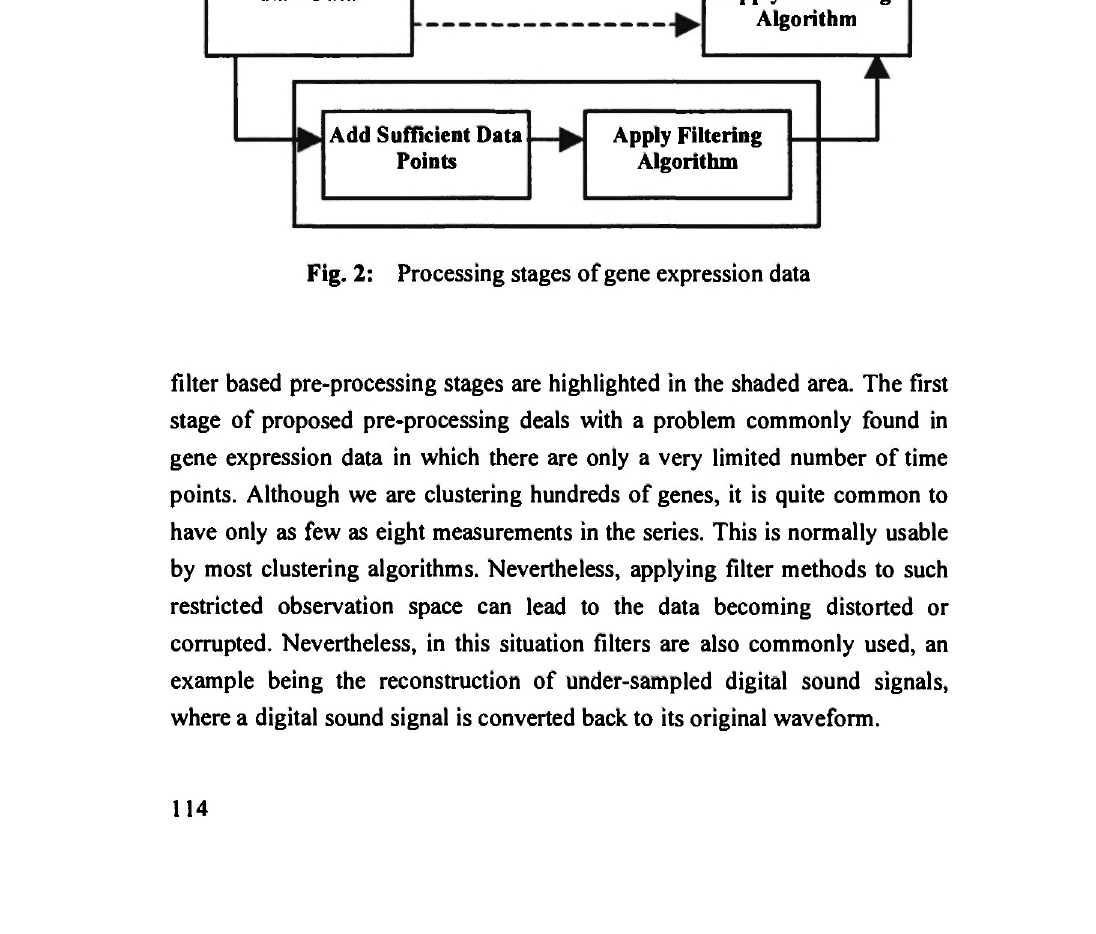
Fig. 1: Example of both Moving average and Fourier filters